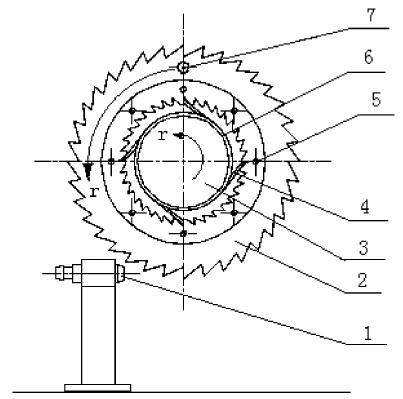
Figure 3. The structure principle of the balance disk. Notes: 1 Nozzle mechanism; 2 balance disk body; 3 spindle; 4 elastic claw; 5 thread hole; 6 installing ring; 7 unbalance hole.